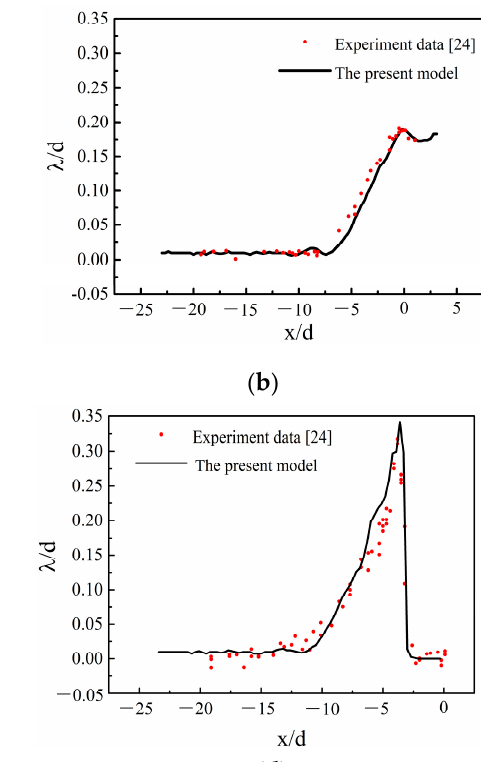
Figure 3. FEM mesh used in the computation for seabed in the vicinity of the foundation trench.